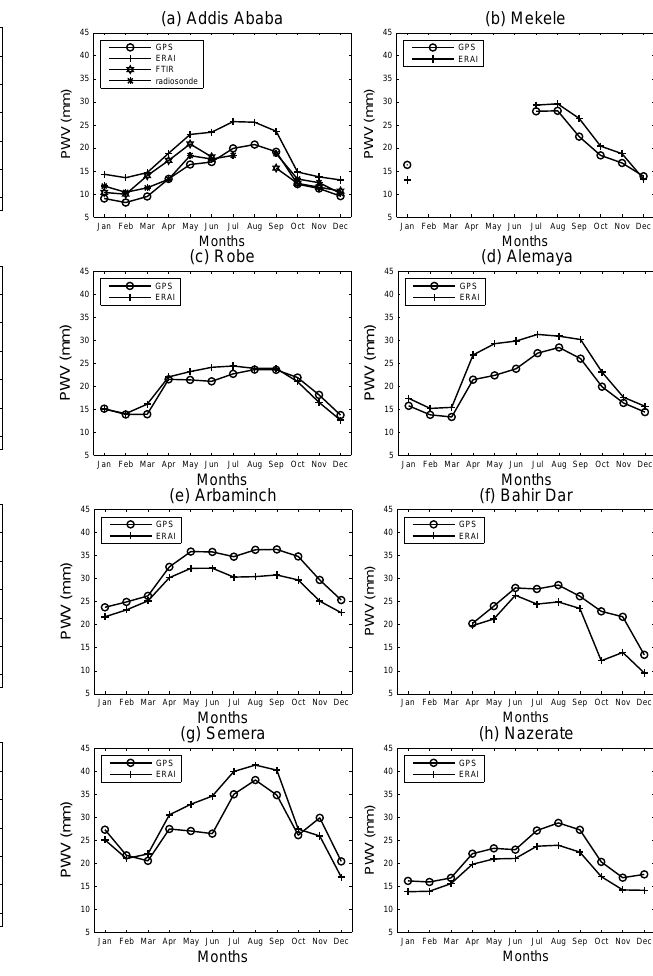
Figure 11. The same as Fig. 9 for ERA-Interim versus GPS but sep- arated into seasons: MAM (a–b) , JJA (c–d) , SON (e–f) and DJF (g– h) .